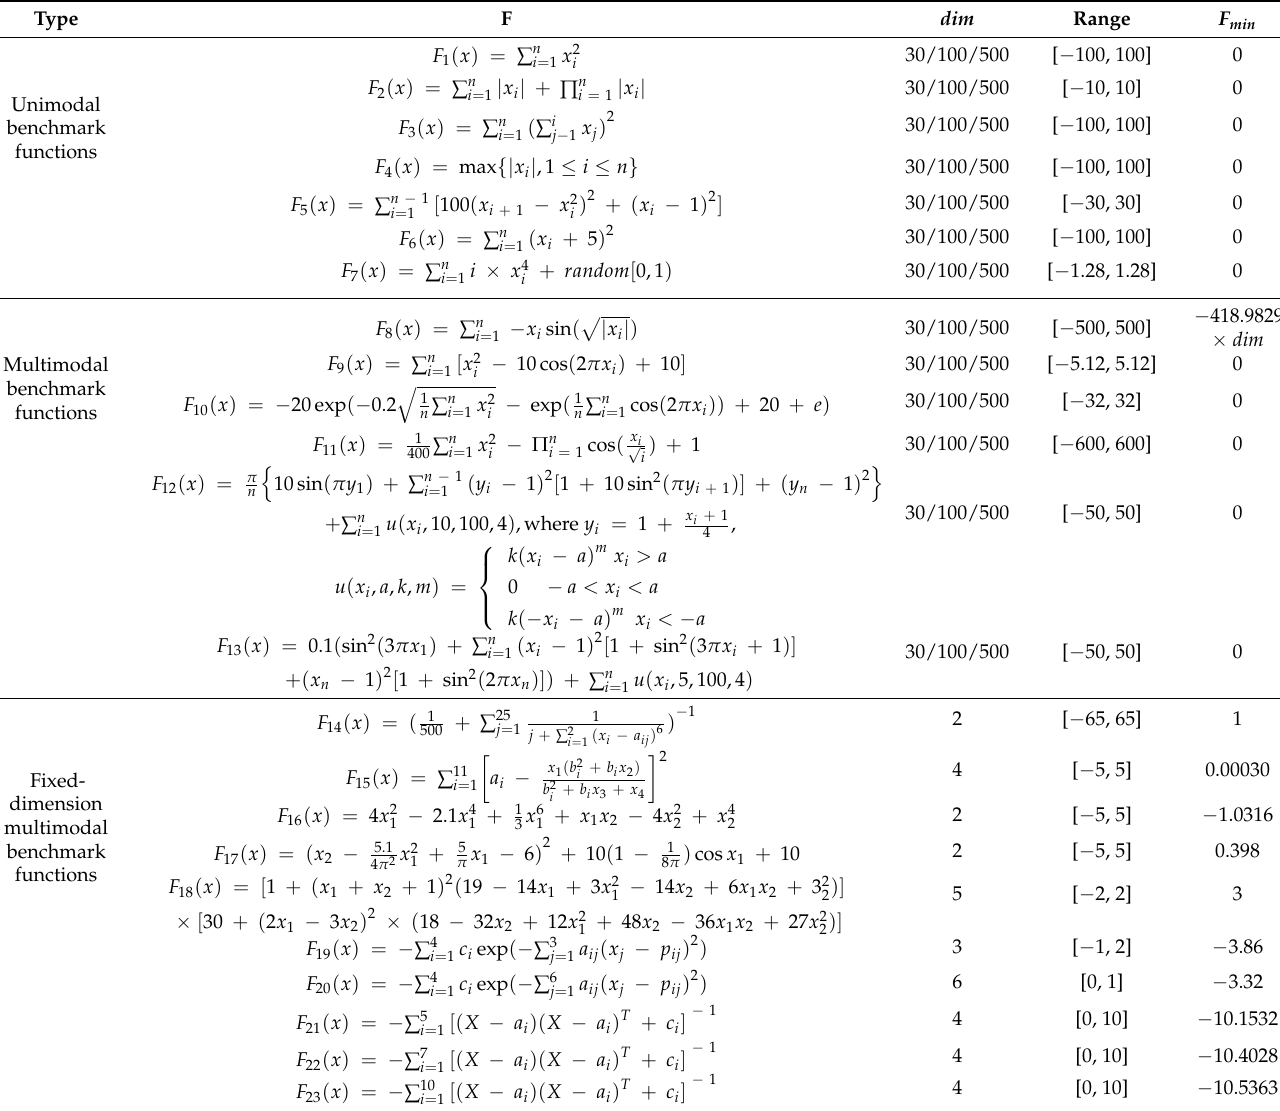
Table 2. Details of 23 benchmark